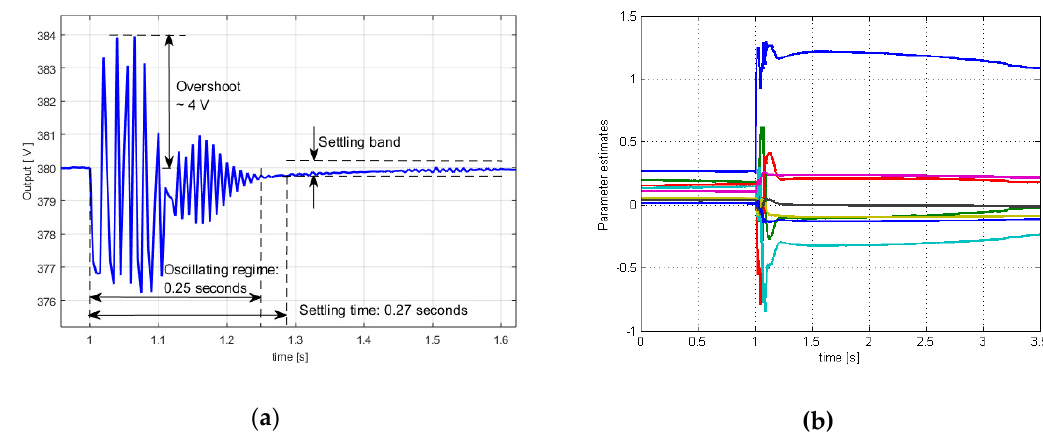
Figure 7. Mechanical torque variation—4th order model: ( a ) Terminal voltage—zoom; ( b ) Parameter estimates.